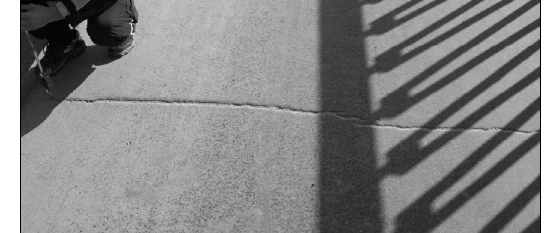
Fig 2. One image of break on the bridge